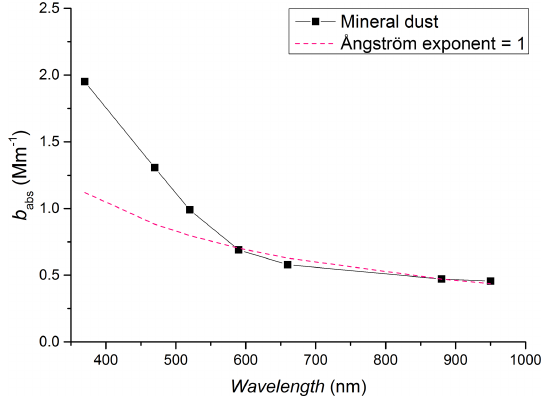
Figure 6. Averaged absorption coefficient during the campaign for ambient dust (as calculated in Eq. 6) in the coarse fraction of aerosols as calculated from the difference of the absorption coeffi- cients measured with a virtual impactor and a PM 1 inlet and divided by the average enhancement factor (black line). The dotted red line shows a theoretical curve with Ångström exponent of 1, extrapo- lated from measurements at 880nm.